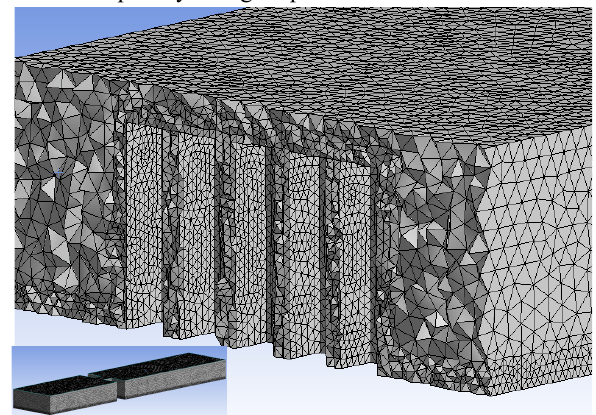
Fig. 3. Unstructured tetrahedral mesh with inflation